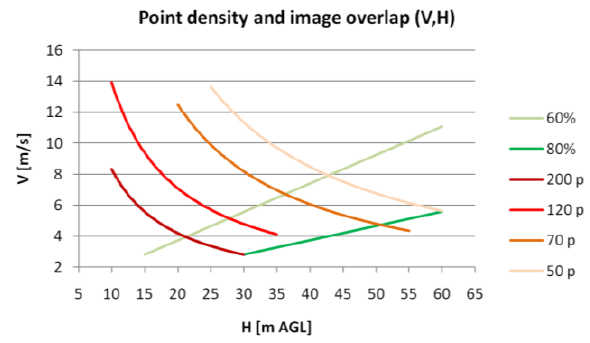
Figure 5. A diagram with optimizing flight parameters for both sensors